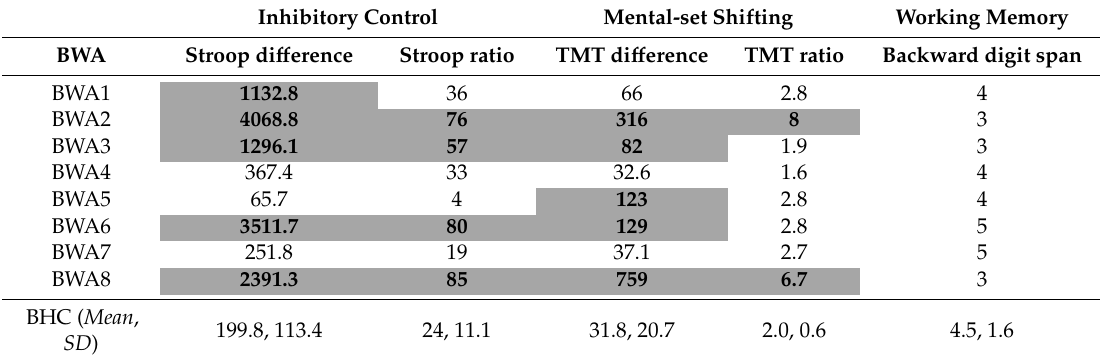
Table 5. Statistical results of single case analysis to compare an individual’s (BWA) test score against control (BHC) for each executive control